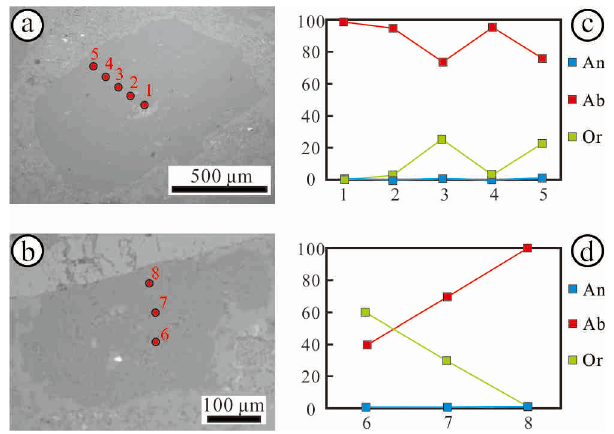
Figure 9. BSE images ( a , b ) and compositional ( c , d ) variation of feldspars from Jinling diorites. The clinopyroxenes exhibit a compositional range of 43.27 wt.%–45.04 wt.% Wo, 42.33 wt.%–44.12 wt.% En, 9.62 wt.%–11.47 wt.% Fs, and 1.14 wt.%–2.02 wt.% Ac (Table 2). In the pyroxene classification ternary diagram, the clinopyroxene samples are plotted in the transitional region between diopside and augite (Figure 10a).